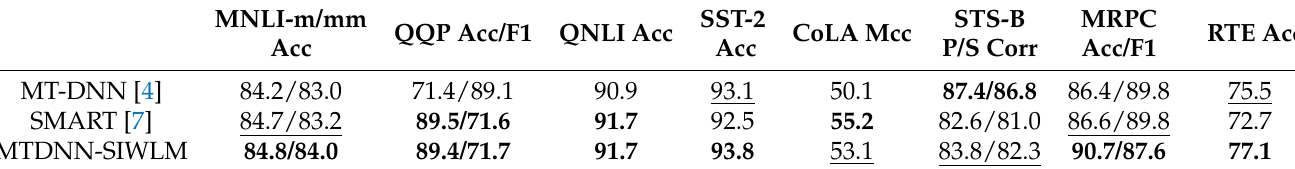
Table 4. Fine-tuned results for eight tasks of GLUE. The best result is in bold font and the second-best result is underlined. For two metrics, we attain the highest performance model by averaging two performances. These GLUE test set results were measured using the GLUE evaluation server on 19 January